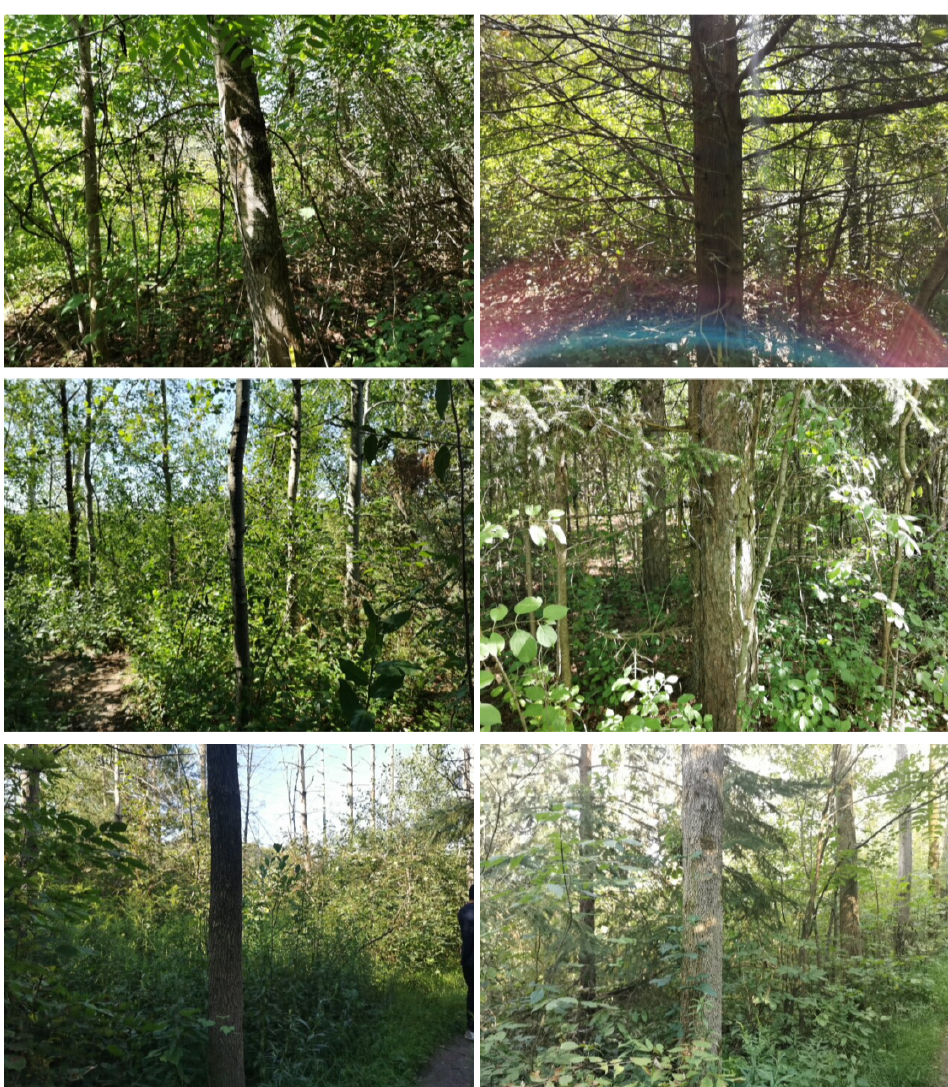
Figure A3. Sample RGB images from the Laurel Creek data set, all taken from roughly 2 m away. The images in the left column are categorized as “low” occlusion because they have few to no branches and leaves in front of the trunk. The images in the right column were categorized as “medium“ or “high” occlusion. In addition to occlusion, the branches, shrubs, and leaves also make it difficult to walk around the